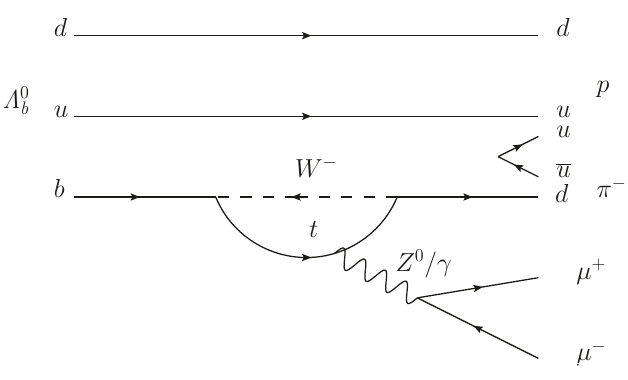
Figure 1 . One of the lowest-order diagrams for the decay (cid:3) 0